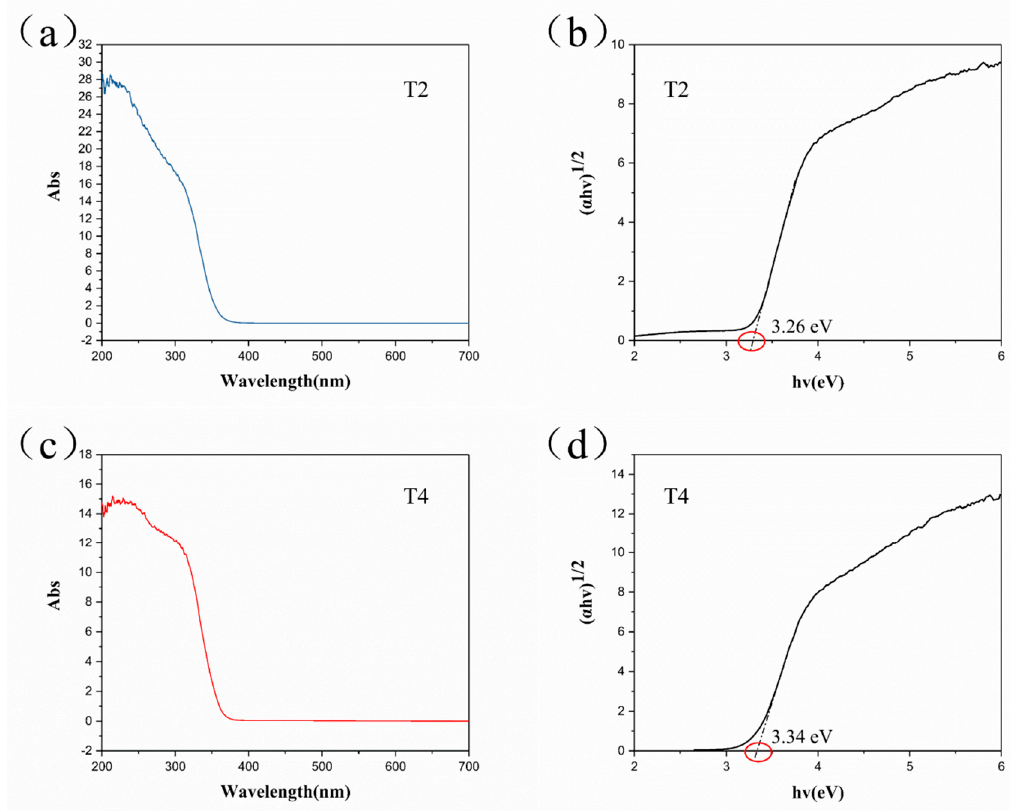
Figure 5. ( a ) UV-vis diffuse reflection and ( b ) calculated energy gap using the Kubelka-Munk equation Figure 5. ( a ) UV ‐ vis diffuse reflection and ( b ) calculated energy gap using the Kubelka ‐ Munk and Tauc plot method of the as-synthesized samples T2 and equation and Tauc plot method of the as ‐ synthesized samples T2 and T4.